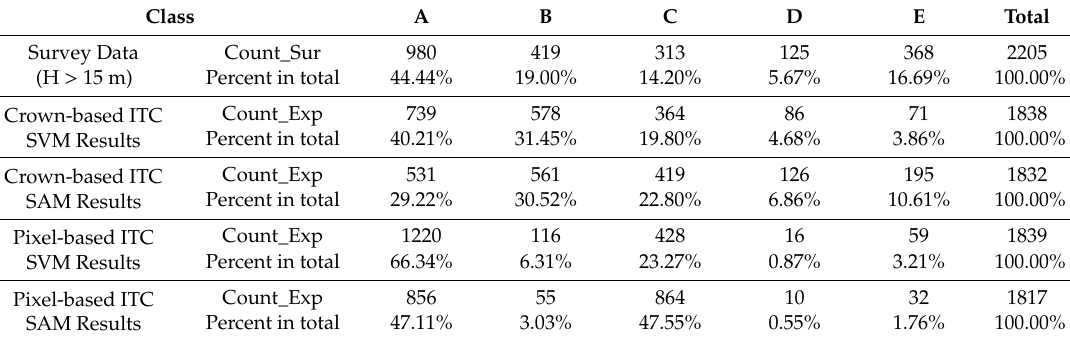
Table 3. Classification result statistics (Count_Sur: Count of Survey data, Count_Exp: Count of Experiments, Percent in total: ratio of count to total, A–E are classes).